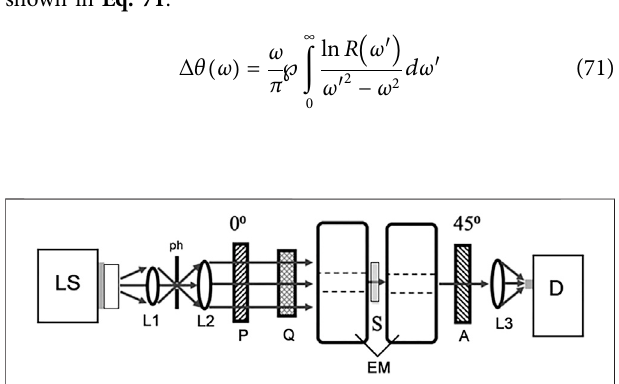
FIGURE 14 | Schematic diagram of the MO spectrometer utilizing the polarization modulation method with a multichannel spectrometer. LS: light source (halogen tungsten lamp), L1 L2 L3: collimating lenses, ph: pinhole, P: polarizer, Q: quarter wave plate, EM: electromagnet, S: sample, A: analyzer, D: multi-channel spectrometer with a 2048-element linear silicon CCD array